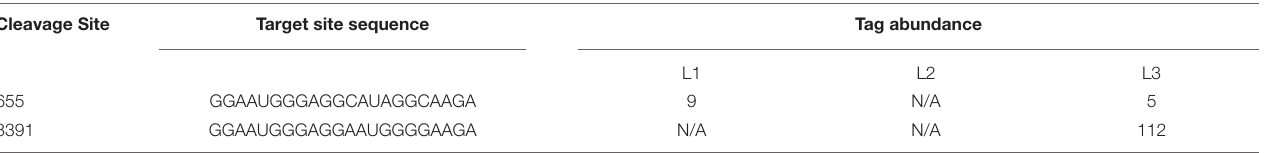
The values in the top section of the table, are the normalized read counts for each replicate per genotype/treatment. The average values are calculated for individual group (R vs. S), and under either mock-inoculation or P. ultimum infection. Different letters (a or b) in front of the average values indicate the significant difference